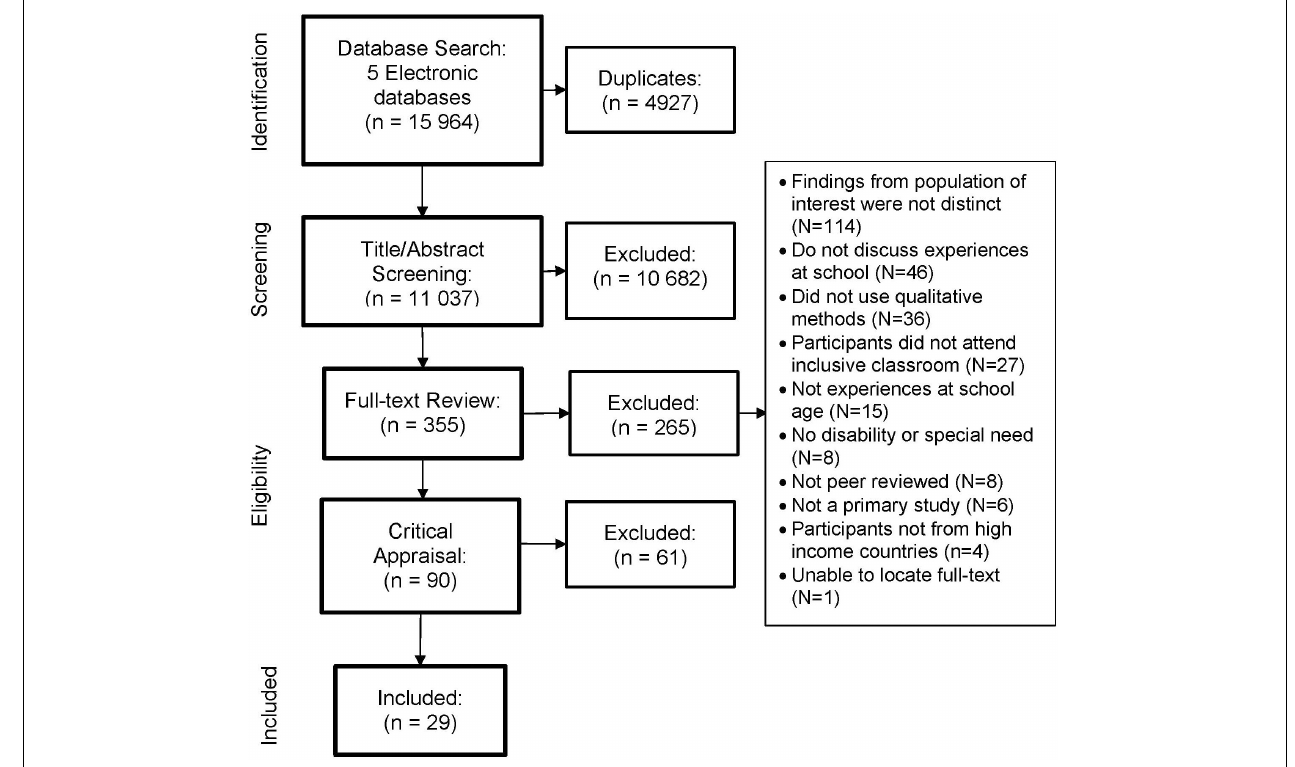
FIGURE 1 | Flowchart outlining the review